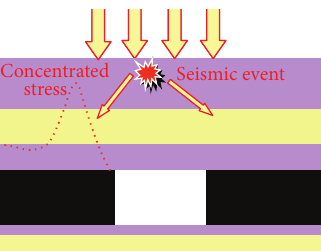
Figure 1: Mechanical structure of static loading type during road- way